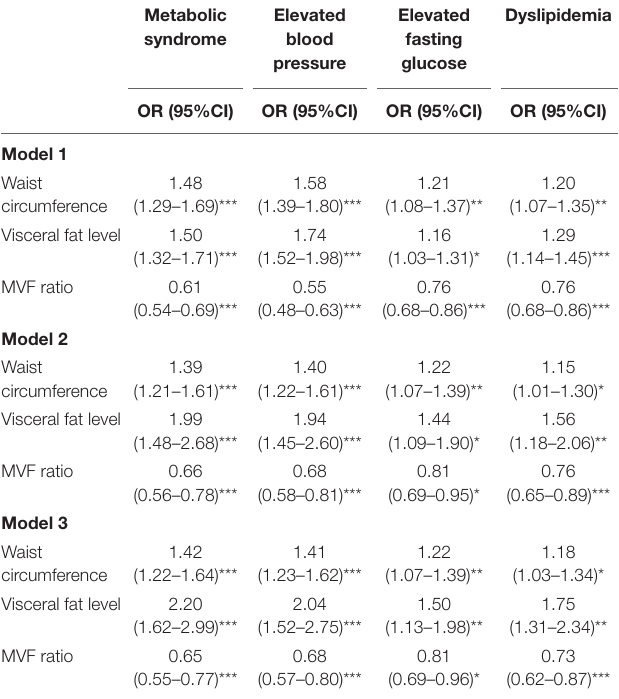
TABLE 2 | Effect of adiposity measurements on the components of metabolic